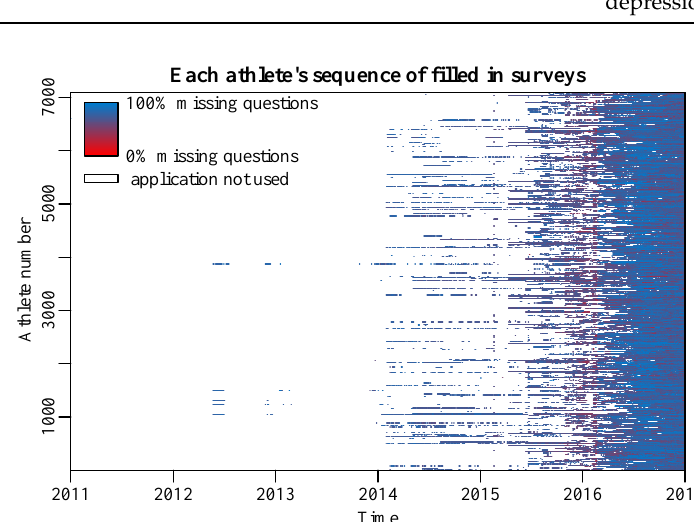
Table 1. Description of types of missingness: missing completely at random (MCAR); missing at random (MAR); missing not at random (MNAR) [14]. MCAR MAR MNAR Meaning Missingness is not correlated with the outcome.